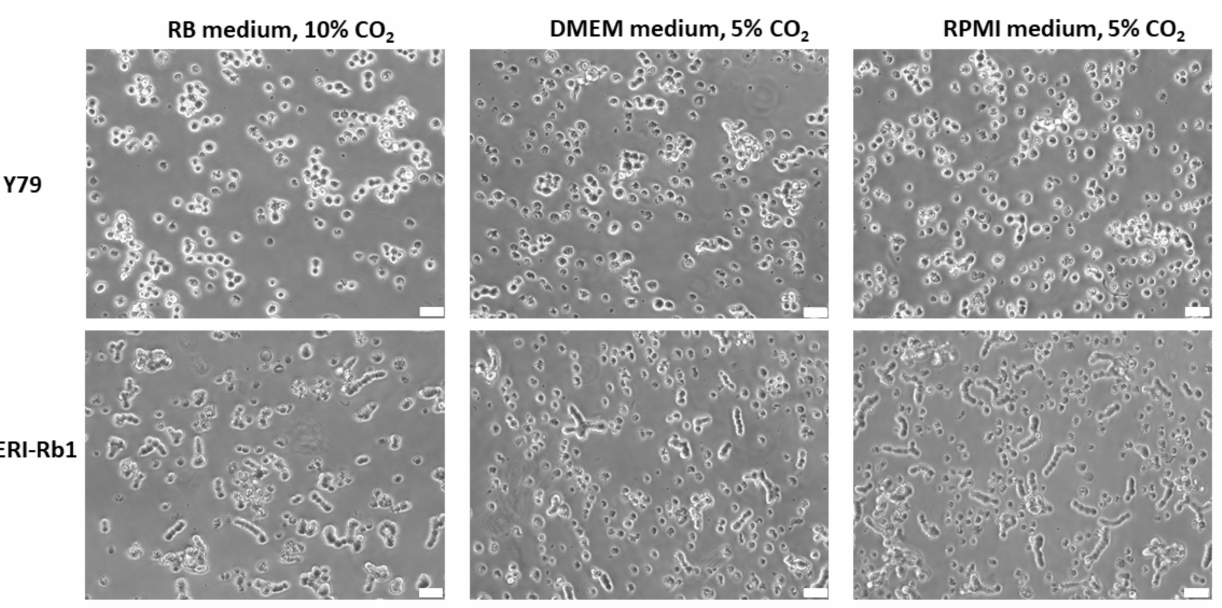
Figure 1. Morphology of Y79 and WERI-Rb1 RB cells in suspension culture grown under the different culture conditions indicated. Phase contrast microscopy photos, white scale bar: 32 µ